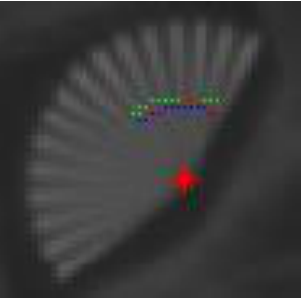
Figure 15. GF-1 panchromatic image of fan-shaped